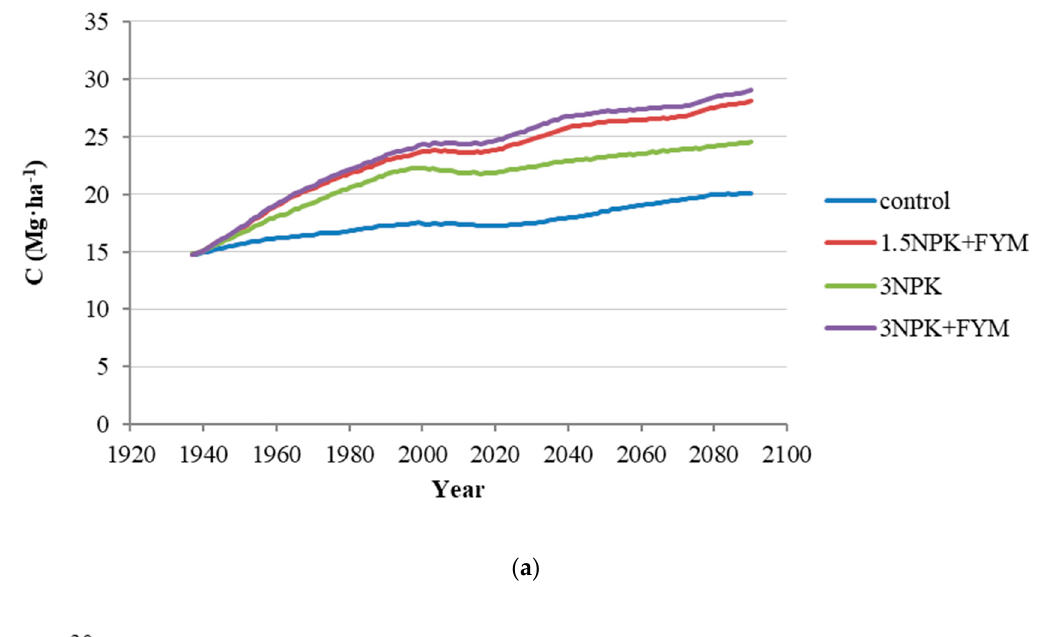
Figure 4. Simulated annual dynamics of C in the resistant plant material (RPM) pool in the DAOS 4 experiment: ( a ) RCP4.5 and ( b ) RCP8.5.